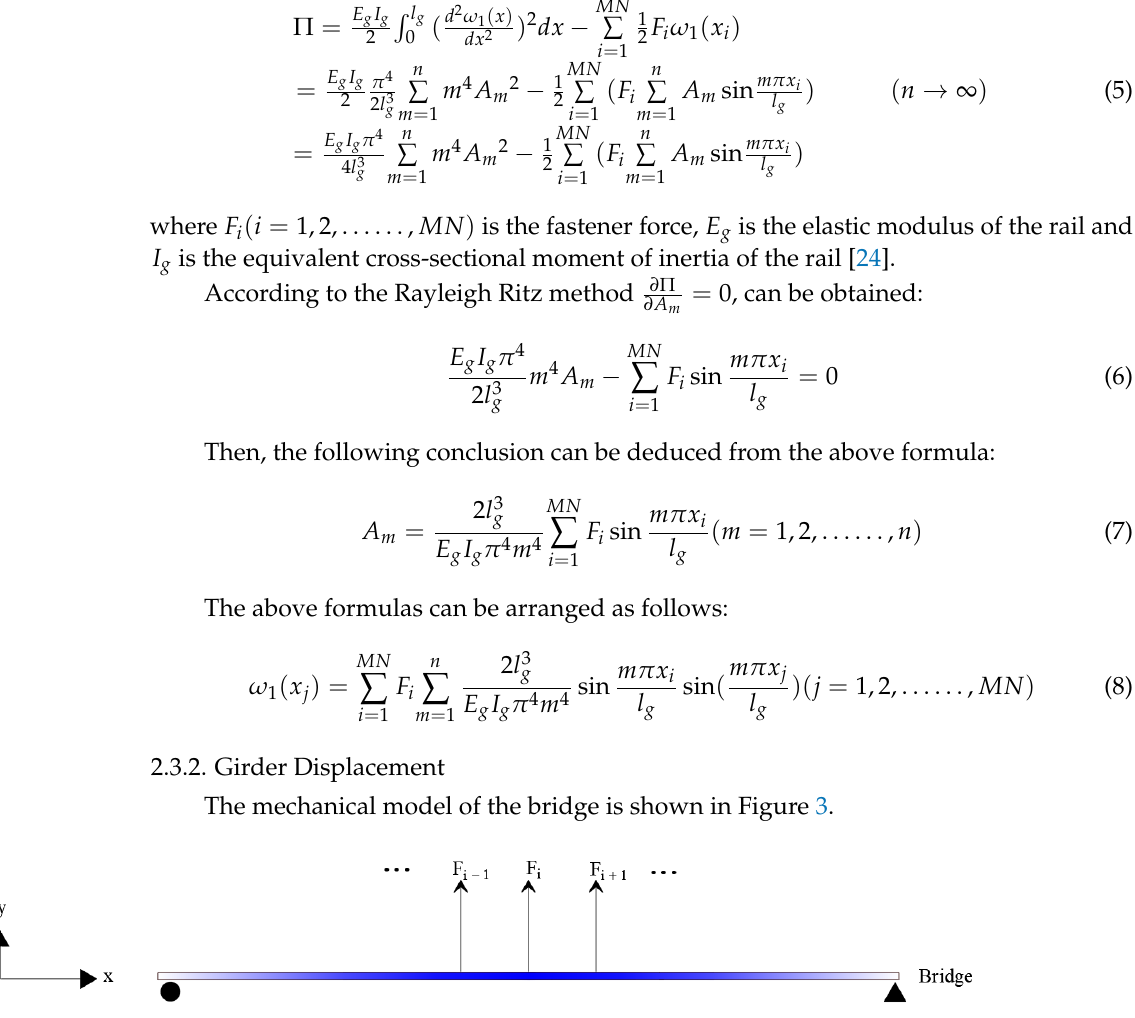
Figure 3. Mechanics model of the bridge.